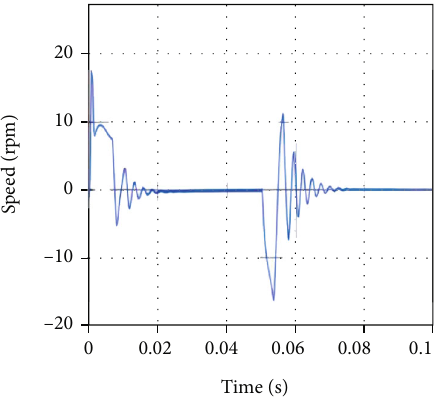
Figure 28: Speed estimation error for proposed method at Case 2.